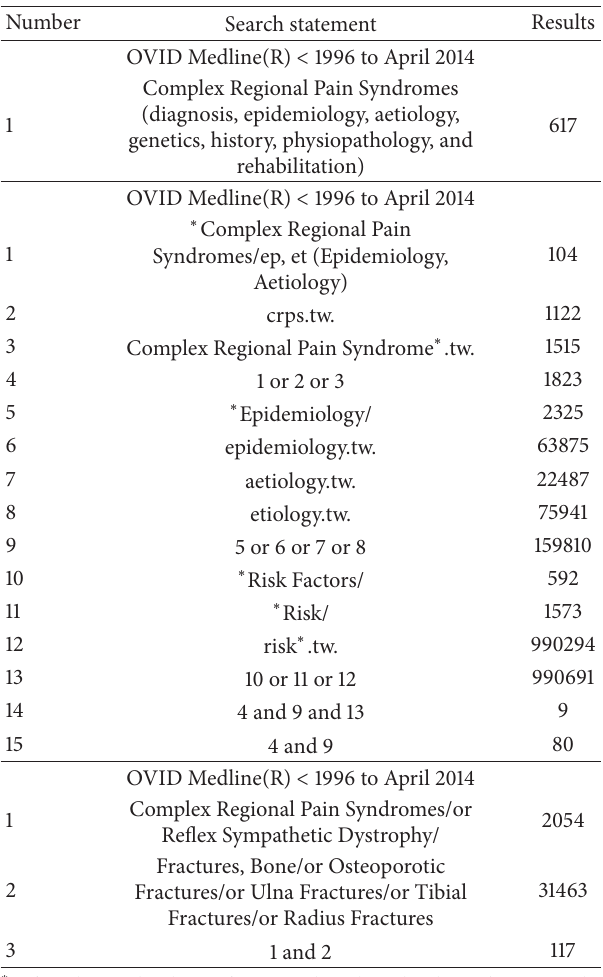
Table 2: Search terms for OVID Medline(R) CRPS 1